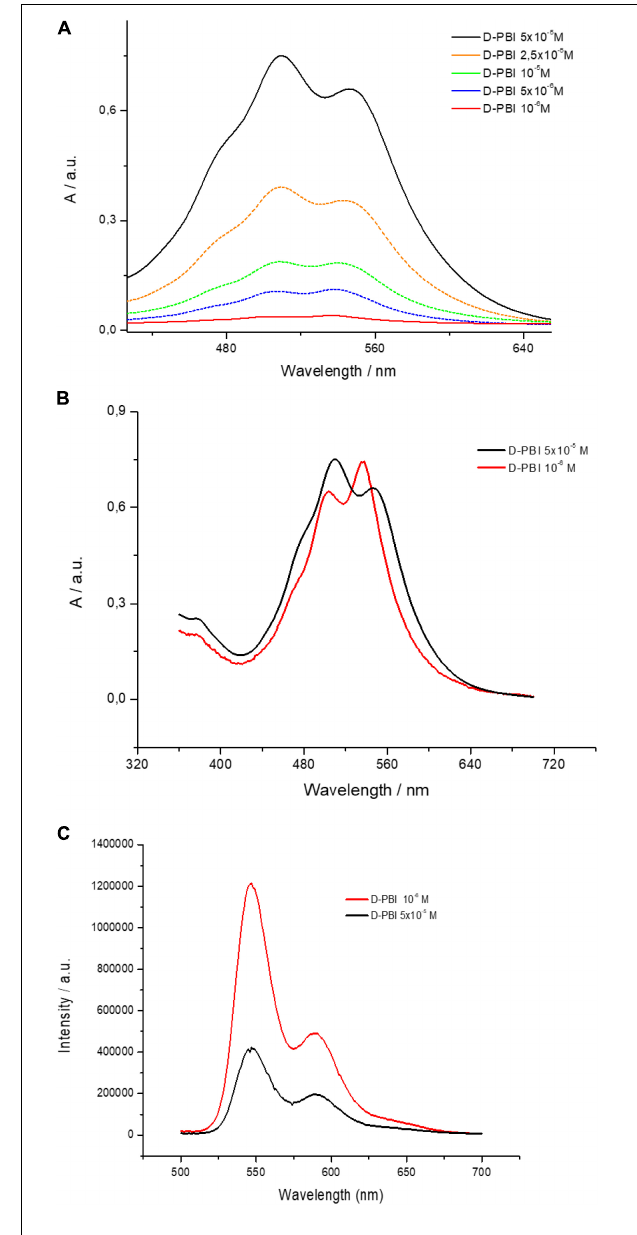
FIGURE 1 | Perylene bisimide (PBI) derivative chemical structure.